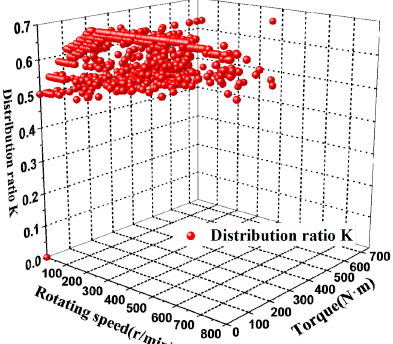
11 of 17 Figure 8. The demand torque/power in the China urban passenger driving cycle (CUPDC).